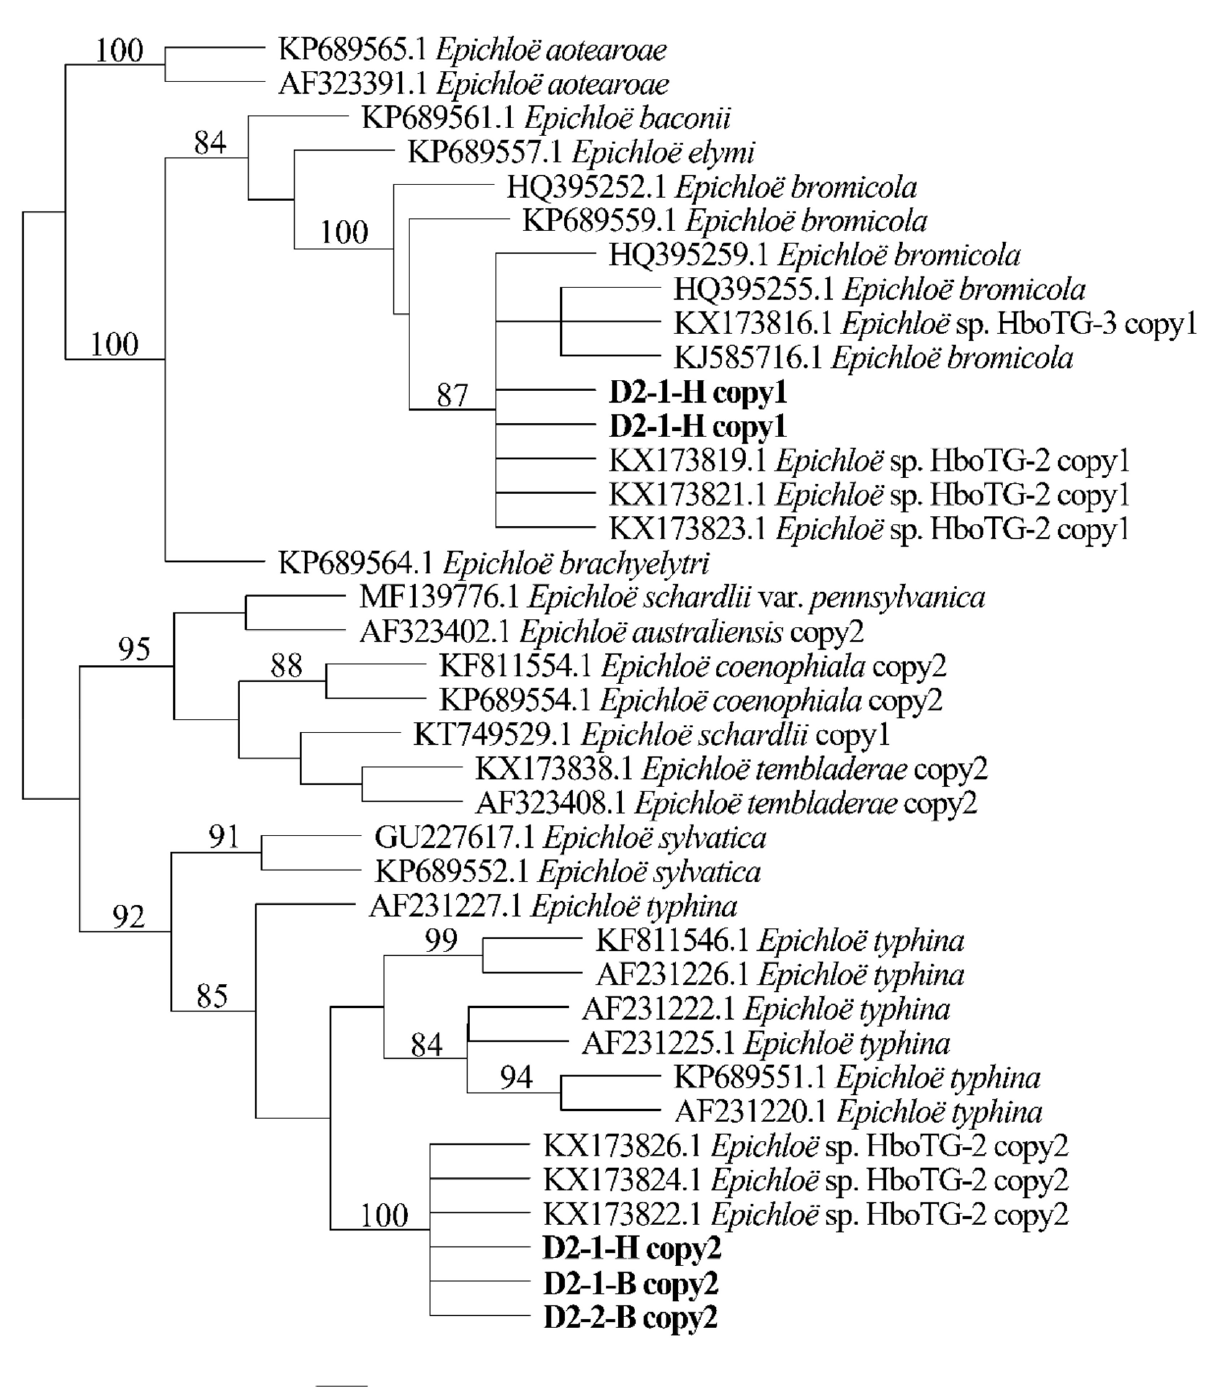
Figure 5. Phylogeny derived from maximum parsimony (MP) analysis of the tefA gene from repre- sentative Epichloë species and the copies of the hybridized endophytes isolated from H. bogdanii